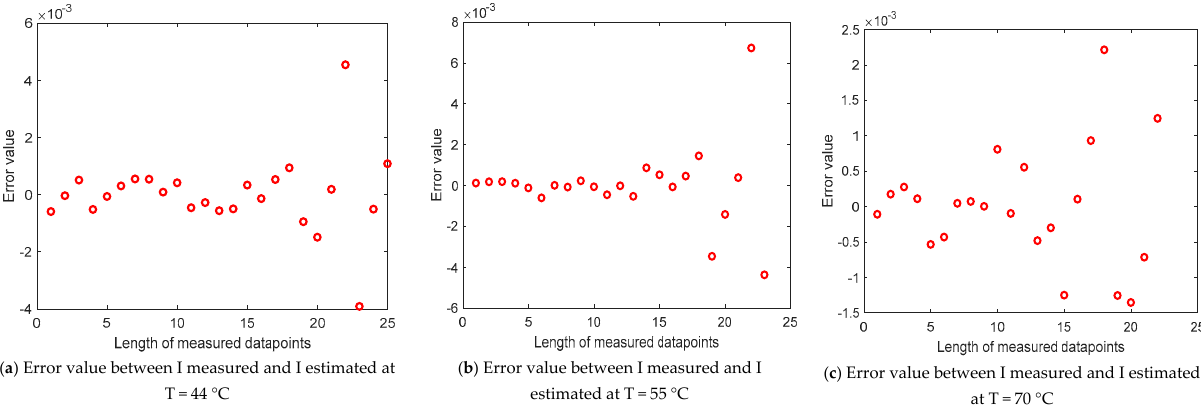
( c ) Error value between I measured and I estimated at T = 55 °C at T = 70 °C Figure 19. Depiction of error value between all I measured and estimated data on SDM on ST40 module at different T and G = 1000. Table 14. Comparison at T = 25 ° C and various G.